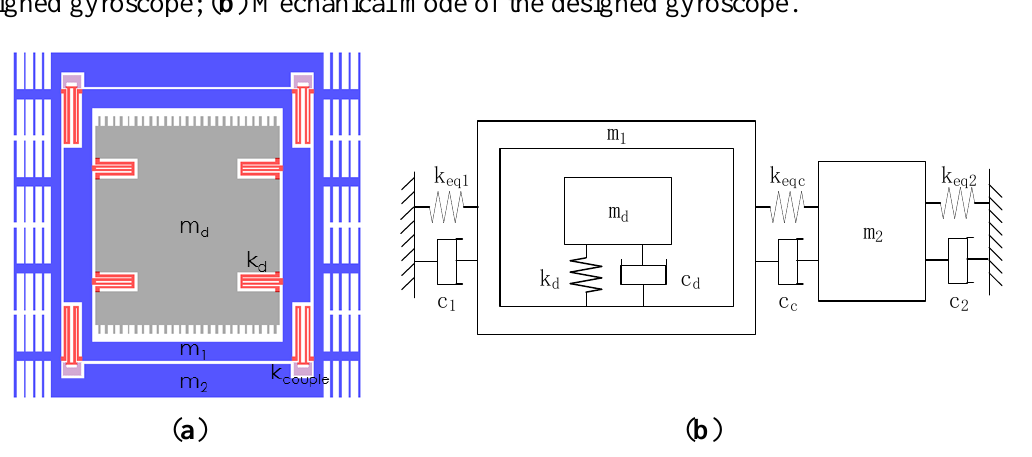
Figure 3. The MEMS gyroscope with a weak coupling spring system. ( a ) Schematic of the designed gyroscope; ( b ) Mechanical mode of the designed